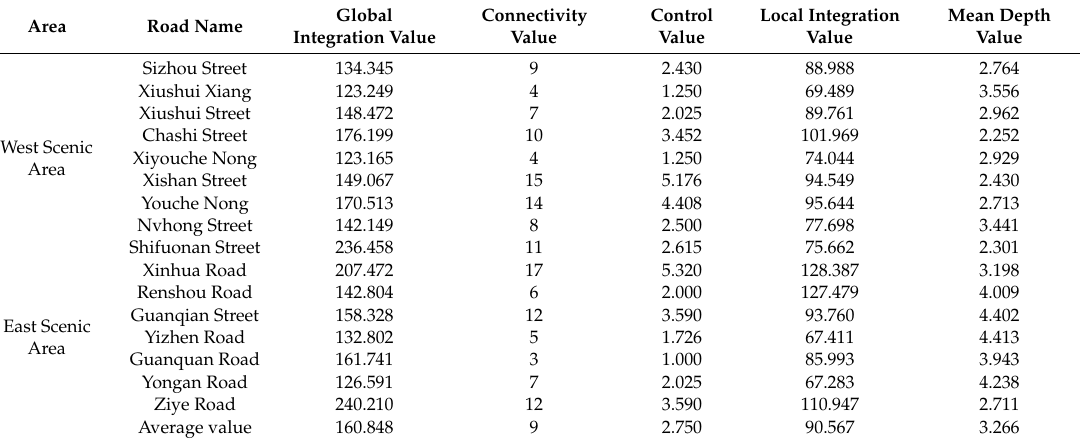
Figure 10. The space syntax model analysis results on Wuzhen town: ( a ) global integration value, ( b ) connectivity value, ( c ) local integration value, and ( d ) mean depth value. Table 4. Space syntax analysis variables of ancient town area in